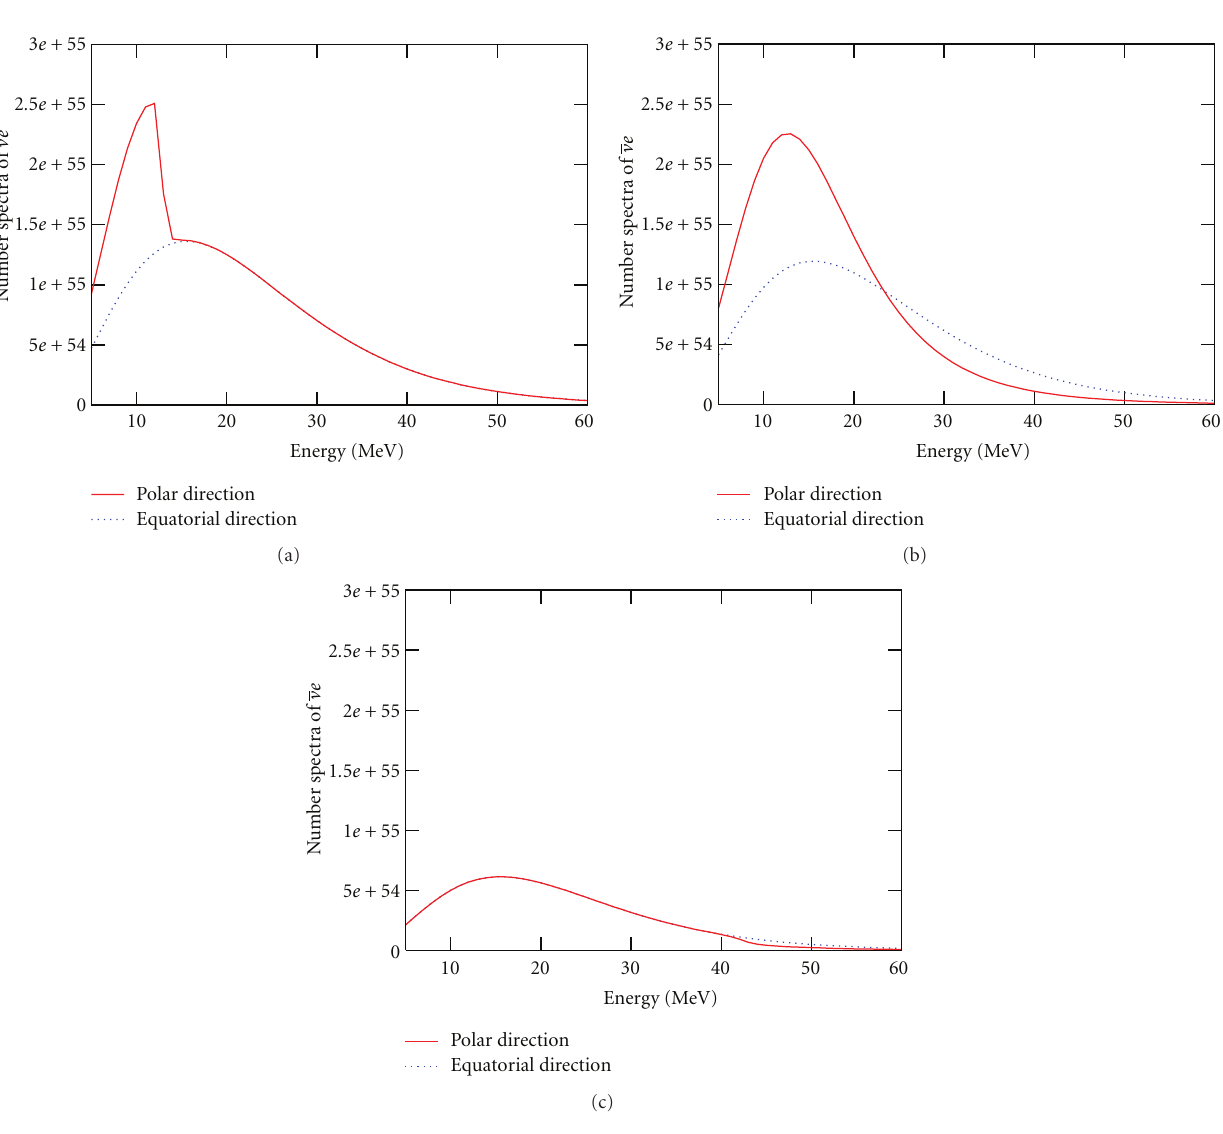
Figure 27: ν e spectra at the surface of the star in the case of (a), (b), and (c). We assume that the inverted mass hierarchy and sin 2 2 θ 13 = 10 − 3 . The solid lines (red lines) and the dotted lines (blue lines) are the spectra of polar direction and equatorial direction, respectively. Note in this figure that the neutrino luminosity and spectra are modeled to be the same as those obtained in a 1D full-scale numerical simulation by the Lawrence Livermore group [91]. These figures are taken from